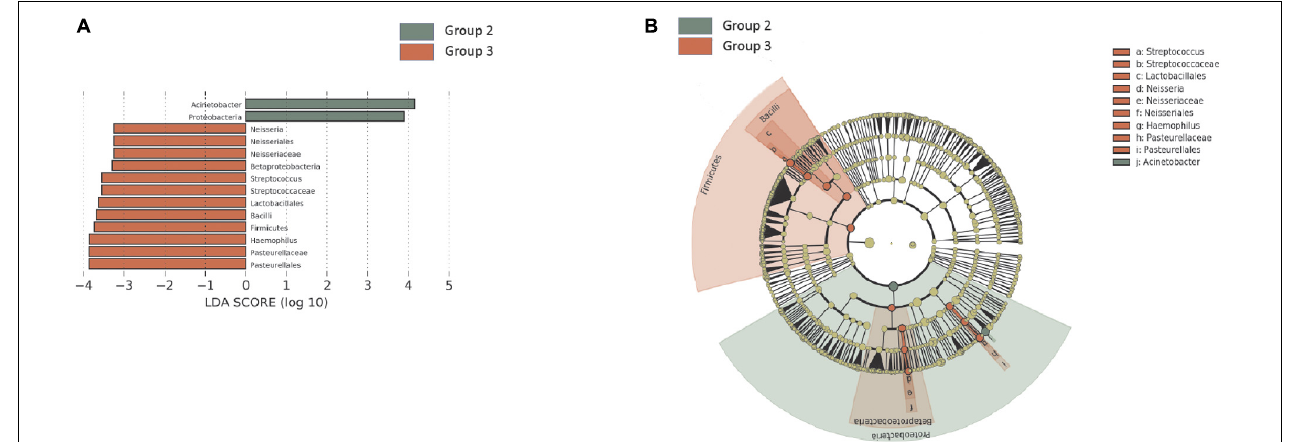
FIGURE 2 | Summary of the linear discriminant analysis (LEfSe) comparing group 2 with group 3. (A) LDA scores and (B) cladogram show significantly different taxa [ p < 0 . 05 and Log 10 (LDA score) > 3.0]. Among H. pylori -positive patients ( n = 32), relative abundance of Firmicutes, especially Streptococcus and Lactobacillales, was significantly increased in group 3 compared with that in group 2. Group 2: H. pylori -infected patients without mucosal atrophy and metaplasia by histology with pepsinogen I/II ratio > 4.0 ( n = 15); group 3: H. pylori -infected patients with atrophic gastritis and/or intestinal metaplasia by histology and pepsinogen I/II ratio < 2.5 ( n =